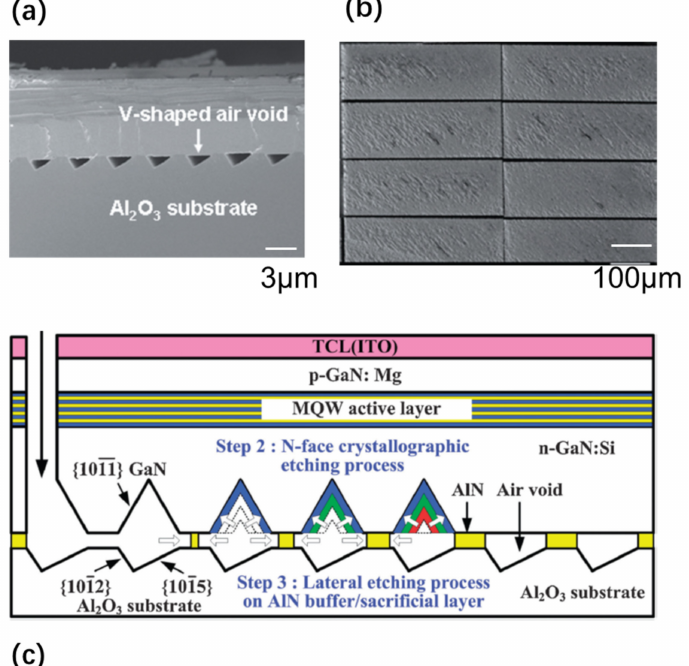
Figure 3. ( a ) An LED epitaxial layer was grown on the patterned sapphire substrate with V-shaped void channels. ( b ) The individual LED chips defined through the laser scribing process were lifted off from the void structures. ( c ) Schematic diagram of the multiple-quantum-well (MQW) LED structure topped with a transparent conductive layer (TCL) ITO for the chemical lift-off (CLO) process. Adapted with permission of [42]. Copyright Applied Physics Express,